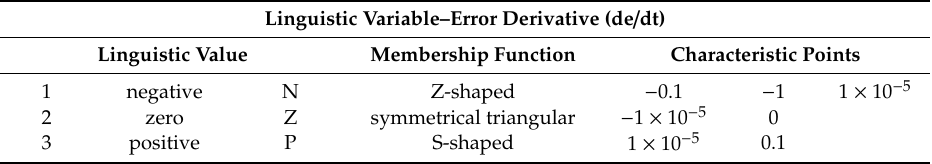
Table 8. The second version of the controller–error derivative.